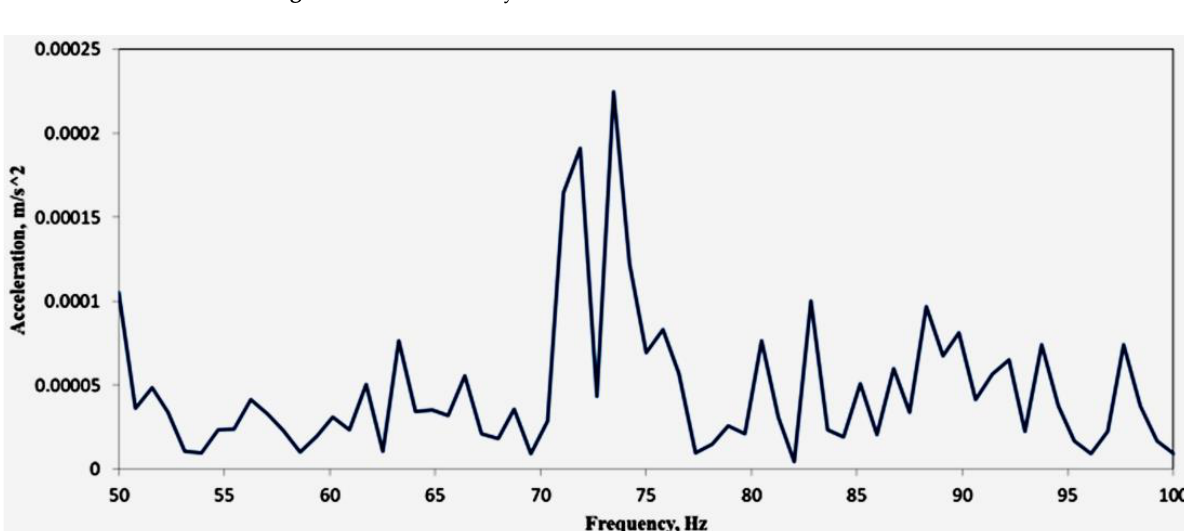
Figure 10. FRF of single crack blade. For FRF spectrums, it was also observed that the amplitude or peak of the spectrum is different for different types of faults. The amplitude of vibration for the healthy blades was found to be 0.00018 m/s 2 , as shown in Figure 9. For the faulty conditions such as single crack blade, two cracks in adjacent blades and mechanical looseness, the amplitude of vibrations were 0.00022 m/s 2 , 0.00045 m/s 2 and 0.00047 m/s 2 , as seen in Figures 10–12, respectively. Therefore, it can be concluded that the intensity of the crack increases, the stiffness of the blade reduces and the amplitude of vibrations